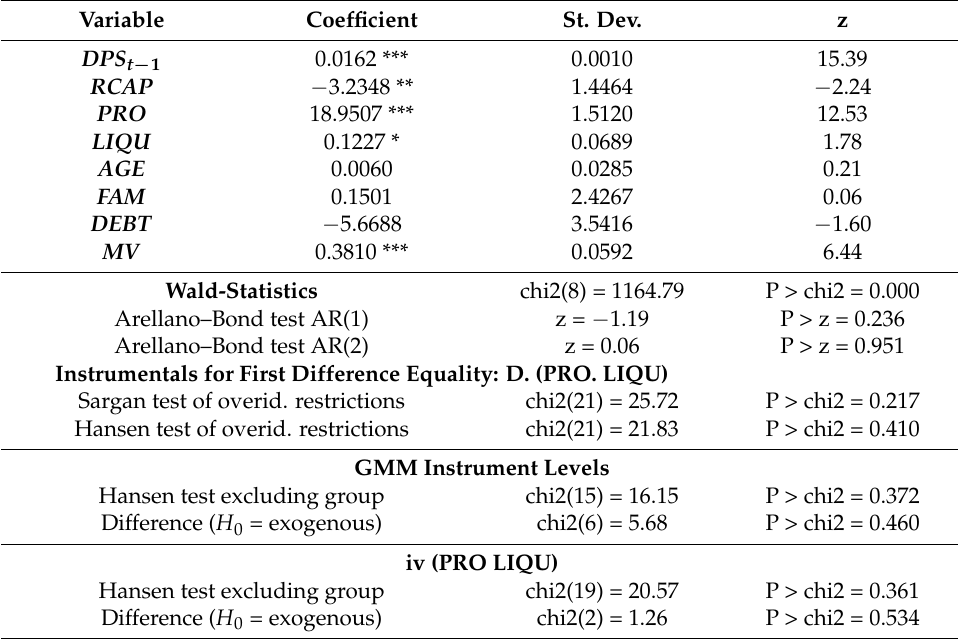
Table 5. Two Step System GMM Dynamic Panel Regression